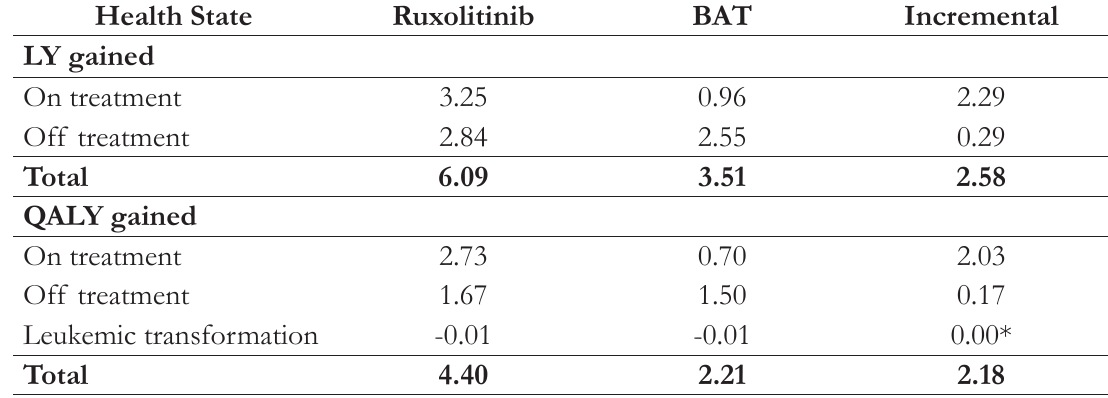
Table 5. Clinical Benefit Estimated with Ruxolitinib and BAT Use